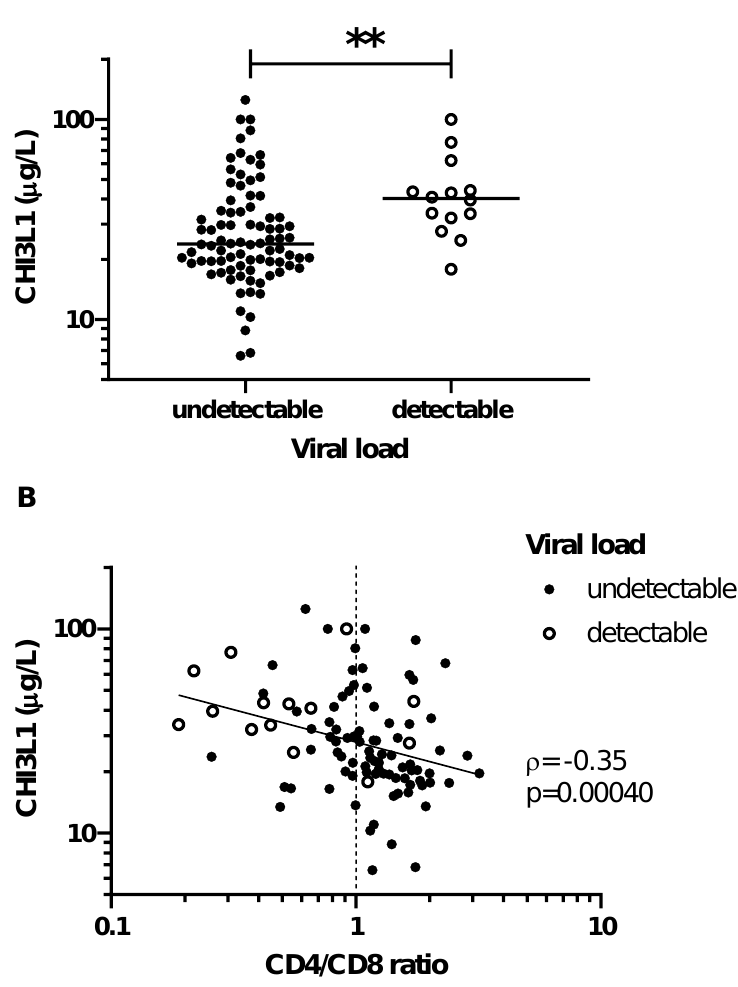
Figure 2. CHI3L1 is associated with poor virologic control among children living with HIV. ( A ) Patients with detectable viral load (solid circles) had significantly more CHI3L1 than those with undetectable viral load (open circles) (** p = 0.0047). ( B ) CHI3L1 and CD4/CD8 ratio were inversely correlated. Concentrations of CHI3L1 were measured by ELISA, and CD4/CD8 lymphocyte counts were taken from patient clinical chart records. Non-parametric Spearman’s rank correlation coefficient ( ρ ) and the associated p -values are indicated.